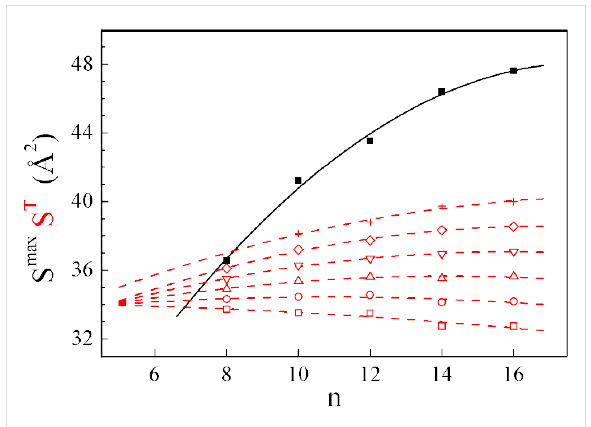
Figure 9: Variations with chain length of the maximum molecular areas close to isotropization S max and of the molecular area isotherms S T in the smectic A phase for the series 1 n with Br − counter-ion: solid squares: S max ; open squares: S 60 °C ; open circles: S 80 °C ; open up triangles: S 100 °C ; open down triangles: S 120 °C ; open diamonds: S 140 °C , crosses S 160 °C ; solid line and dotted lines are parabolic fit of S max and of S T ,